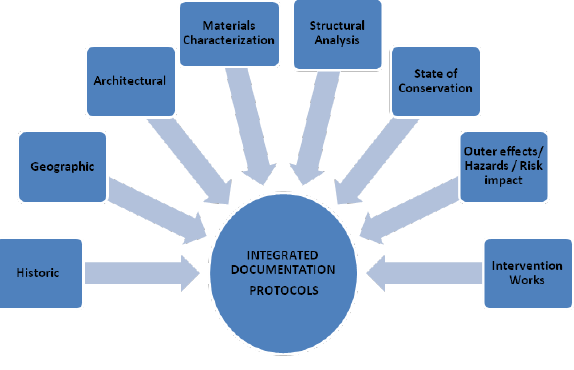
Figure 1. Integrated Documentation protocols data categories